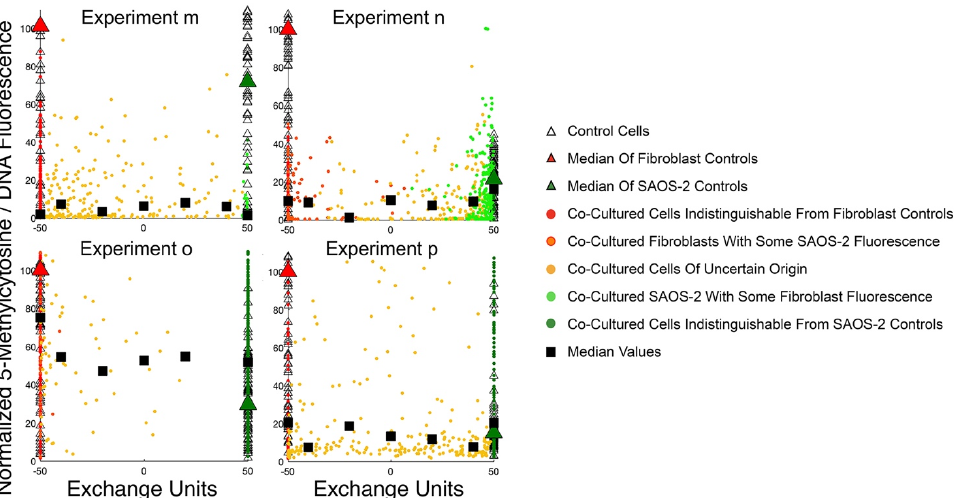
Figure 7. Cartesian plot analysis results for normalised 5mc for all experiments ‘m’ to ‘p’. ‘Red Cells’ comprise fibroblasts in these plots, while ‘Green Cells’ are SAOS-2. Control fibroblasts cultured in isolation (medians shown by large red triangles) had higher normalised 5mc compared with control SAOS-2 (medians shown by large green triangles) ( p < 0.035, paired t-test considering all experiments together; p < 0.015, Mann–Whitney U tests within individual experiments). Co-cultured fibroblasts with fluorescence indistinguishable from controls (red circles) had generally lower normalised 5mc compared with control fibroblasts, (black squares at EU = − 50 are medians of co-cultures; p < 0.25, paired t-test considering all experiments together; p < 0.0025, Mann–Whitney U tests within individual experiments). There was no clear relationship between normalised 5mc in co-cultured cells and distribution according to Cartesian